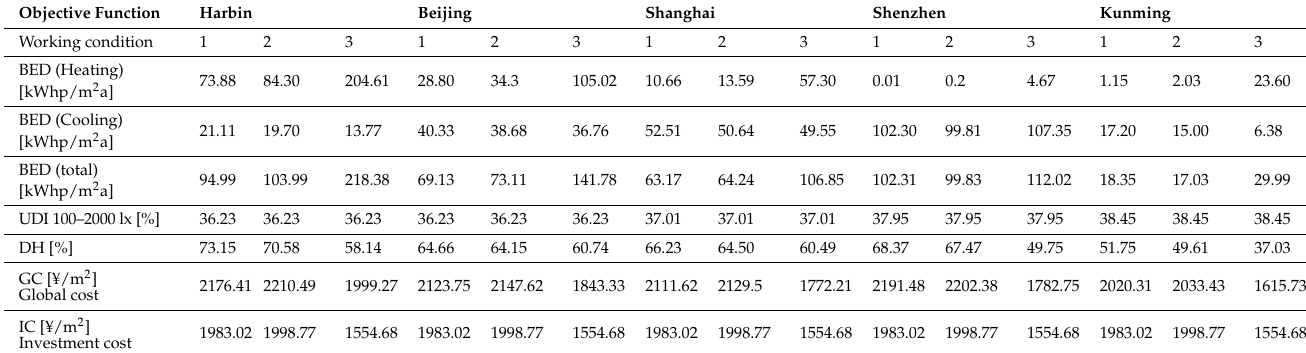
Figure 21. Simulation results of 3 building forms under 3 envelope working conditions and 5 typical urban climatic conditions. Table 14. Average performance indicators for building type 1 under each typical urban climatic condition. Objective Function